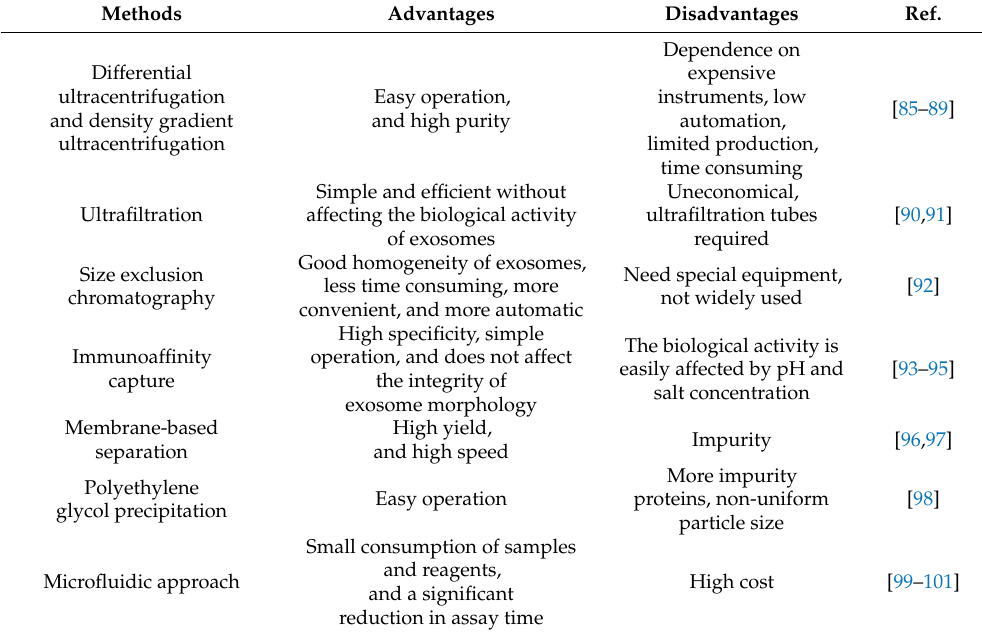
Table 1. Exosome isolation